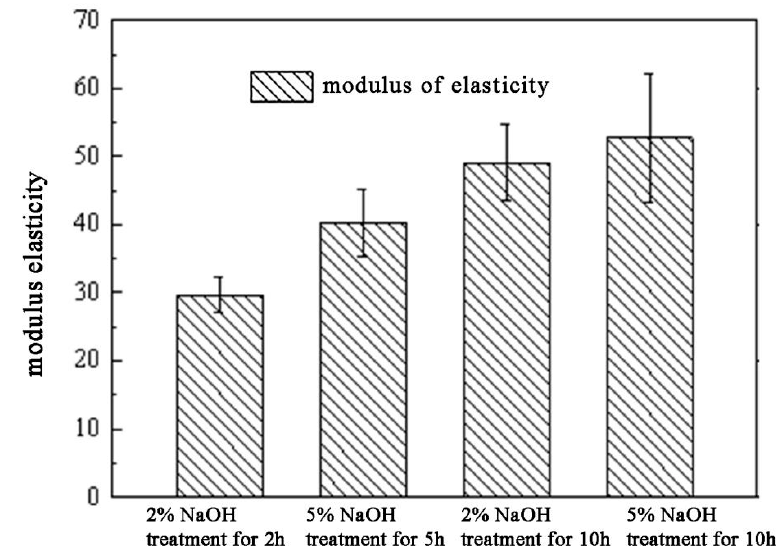
Figure 10. Stress-strain curve.